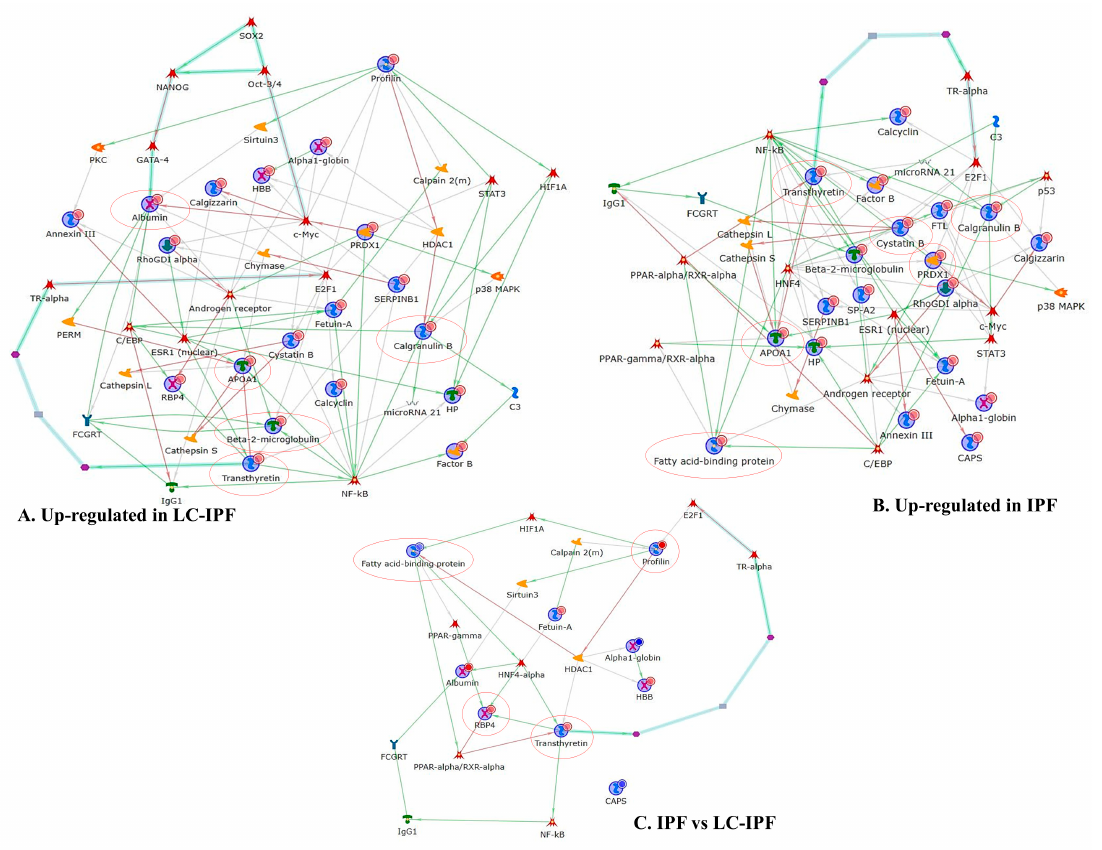
Figure 4. ( A ) Protein network of the up-regulated proteins in LC-IPF with respect to CTRL, and IPF BALF samples. Albumin, Calgranulin B, APOA1, Transthyretin, and Beta-2-microglobulin are the respective central hubs. ( B ) Protein network of the up-regulated proteins in IPF with respect to CTRL and LC-IPF. APOA1, Calgranulin B, Transthyretin, Cystatin B, and PRDX1 are the central hubs. ( C ) Differential proteins between IPF and LC-IPF. Transthyretin, Profilin I, RBP4, A-FABP, and IGHG1 are central hubs (marked by a red